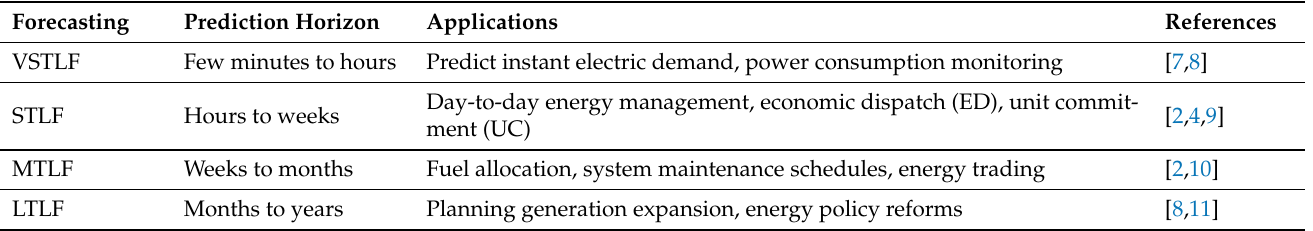
Table 1. Forecasting in different time scales and examples of their